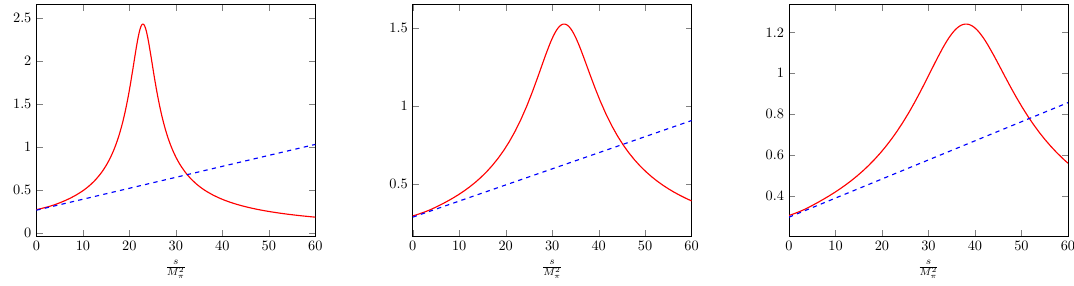
q 4 M 2 (cid:25) Figure 9 . The absolute value of f (cid:25) + (cid:25) (cid:0) ! K + (cid:25) (cid:0) ( s ) =(cid:21) 1 = 2 ( s ) 1 as given in eq. (6.10) (Breit- 1 K(cid:25) s (cid:0) Wigner shaped curves, in red) vs. the one-loop counterpart (straight lines, in blue), as a function of s=M 2 , for s 4 M 2 and for (cid:11) + = 20 : 84 10 (cid:0) 8 , (cid:12) = 1 : 11, whereas (cid:12) + is increased from its central (cid:25) (cid:25) (cid:21) (cid:0) (cid:1) value in eq. (3.17) by 1.5 standard deviation ( (cid:12) + = 1 : 26 10 (cid:0) 8 , left-hand plot), 1.88 standard (cid:0) (cid:1) deviation ( (cid:12) + = 0 : 85 10 (cid:0) 8 , the value retained in the text, central plot), and 2 standard (cid:0) (cid:1)